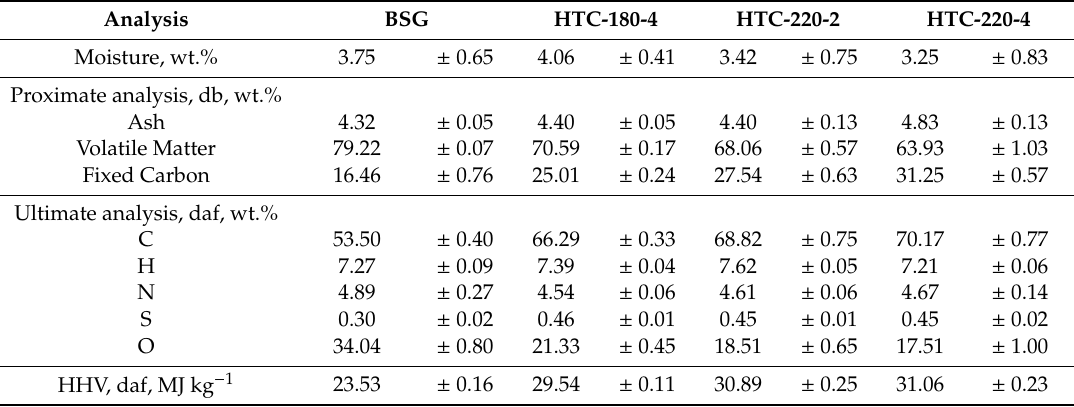
Table 1. Proximate and ultimate analysis of brewer’s spent grains and its